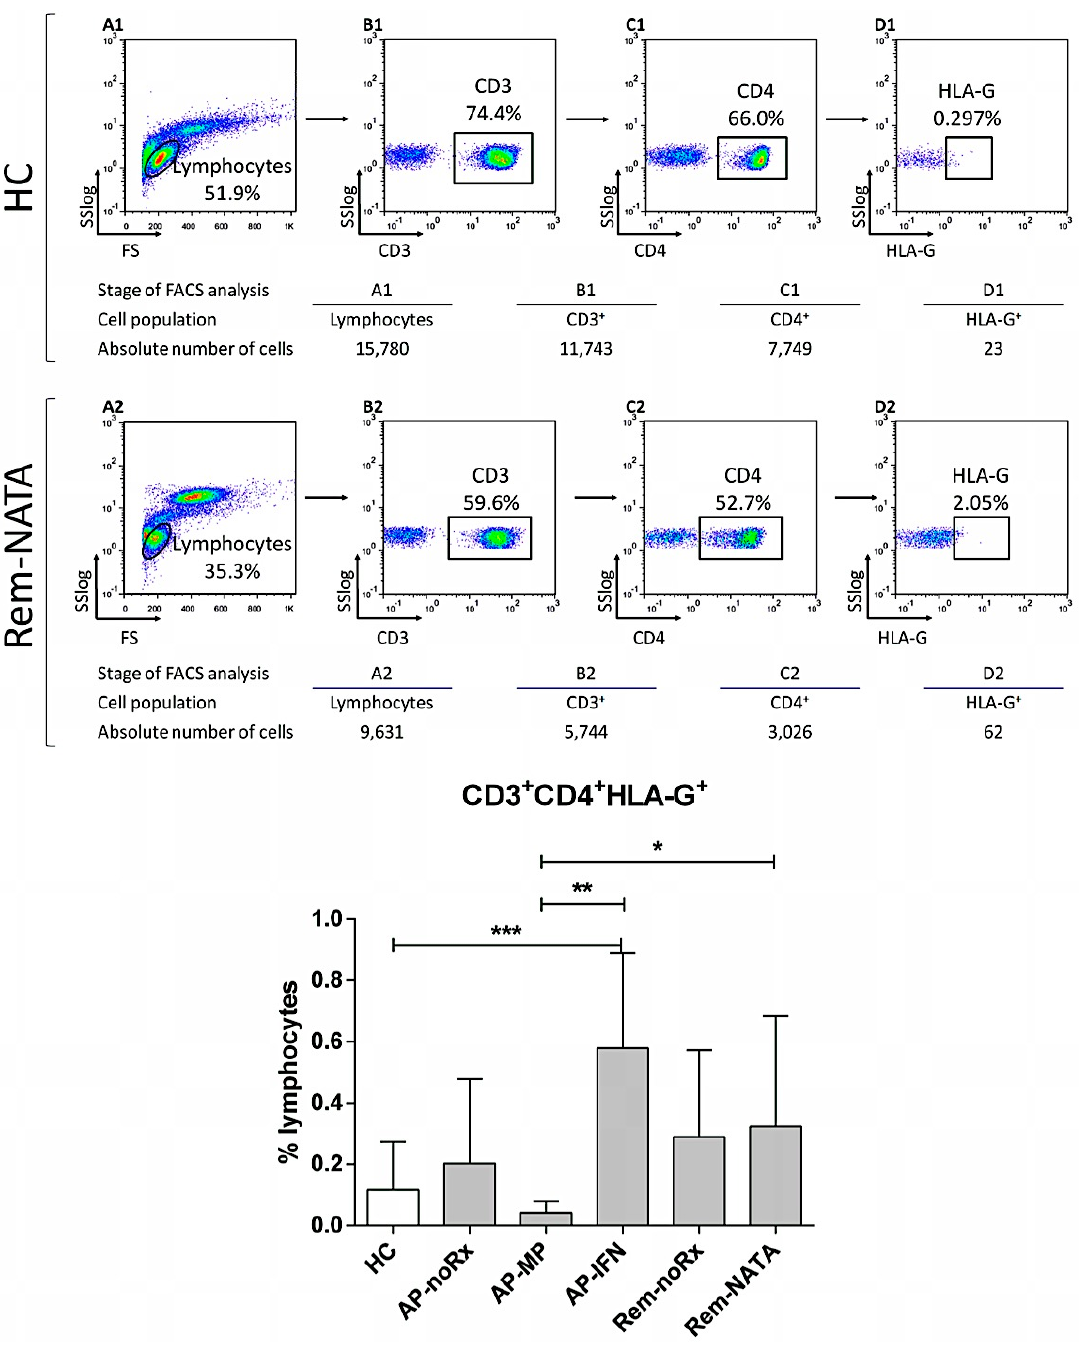
Figure 2. Flow cytometric analysis to determine CD3 + CD4 + HLA − G + RC levels in human peripheral blood. A representative analysis is shown for one healthy control ( A1 – D1 ) and one RRMS patient ( A2 – D2 ); The WBC were gated on lymphocytes, based on forward and side light scatter ( A1 , A2 ) and analyzed for CD3 ( B1 , B2 ), CD4 ( C1 , C2 ) and HLA-G expression ( D1 , D2 ); The numbers in the dot plots indicate the percentage of gated cells expressing the relevant marker. The tables underneath show the absolute number of cells in each population analyzed; Bottom graph: The results of the analysis of all patients ( n = 83) and controls (HC, n = 45). For abbreviations see legend of Figure 1. * p = 0.05, ** p = 0.01, *** p = 0.006.